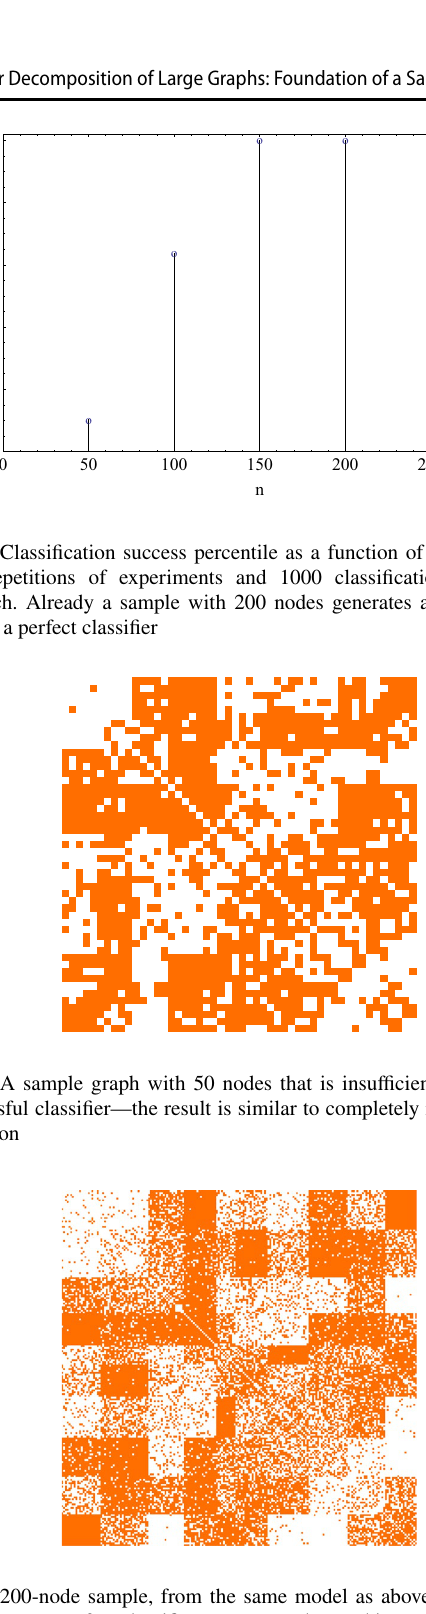
Fig. 7 200-node sample, from the same model as above, that gener- ates almost a perfect classifier—no errors detected in experiments